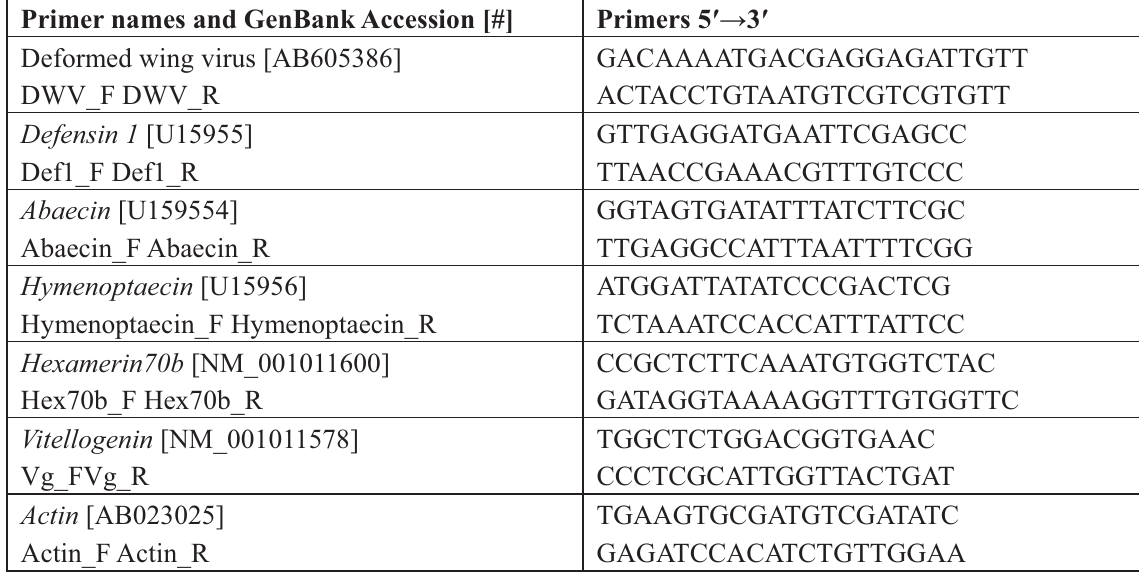
Table 1. List of PCR